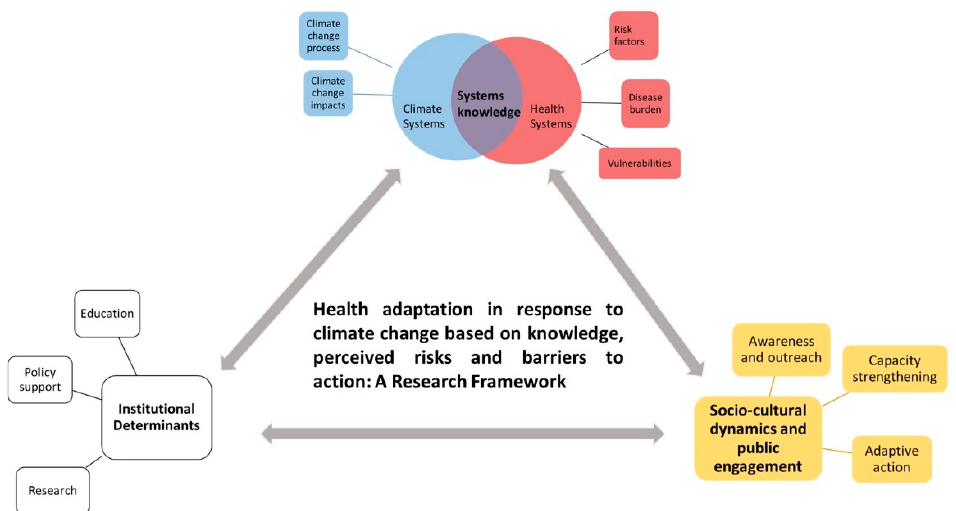
Figure 2. A framework for health adaptation action in the context of climate change based on knowledge and perceived health risks, policy and institutional support and public engagement. The coloured parts highlights the thematic areas we focus on in this paper. The three main components have been shown in bold text.